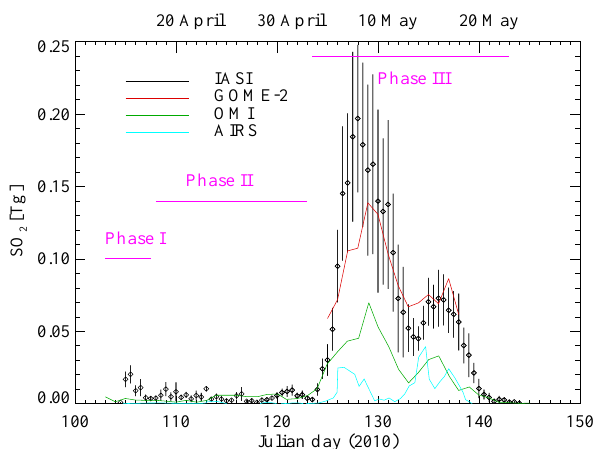
Fig. 10. Estimate of total mass of SO 2 present in the Eyjafjallaj¨okull plume: IASI data (and error bars) are shown in black, GOME-2 values (Rix et al., 2012) are shown in red, OMI values (Thomas and Prata, 2011) are shown in green, and finally AIRS values (Thomas and Prata, 2011) are shown in